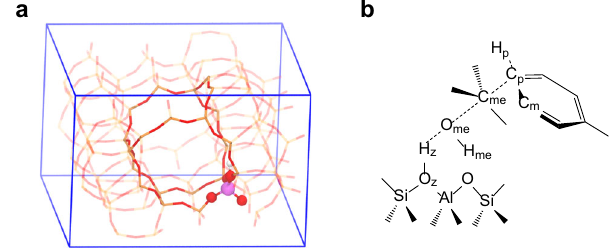
Fig. 2 The catalyst models applied in the simulations. a Structure of the periodic 96 T HZSM-5 model; b illustration of the toluene direct methylation reaction at the Brønsted acid site. Atom labels as referred in the text and will be used throughout the paper.